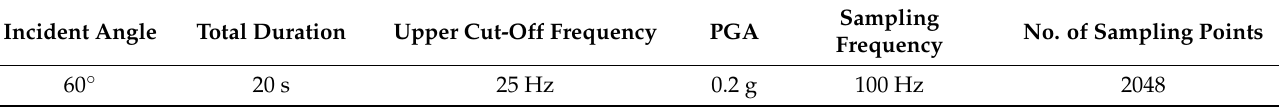
Table 2. Fundamental information of simulated seismic motions.